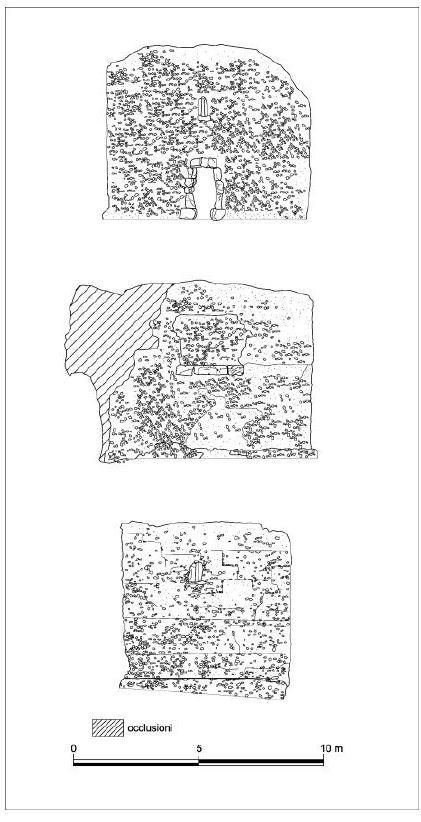
Figure 4. Mausoleum’ surveys by orthophotos.